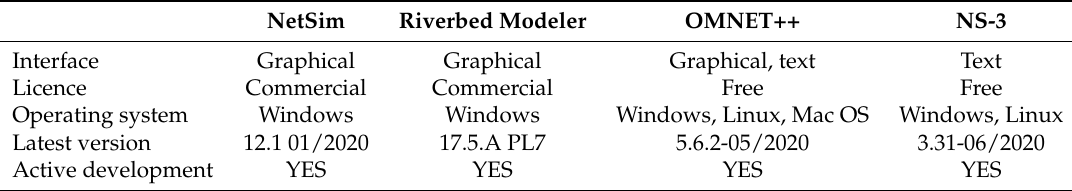
Table 3. Simulators comparison.